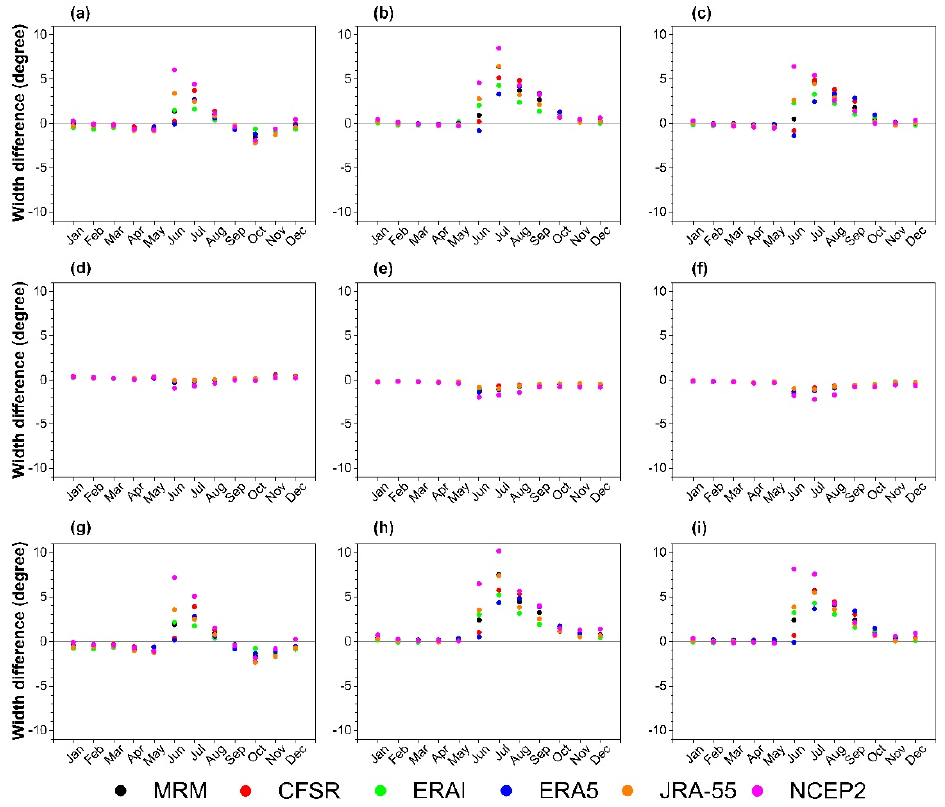
Figure 9. ( a – c ) Annual cycle of the difference between the uncorrected and corrected NH HCW derived from ( a ) M1, ( b ) M2, and ( c ) M3 using the MRM (black), CFSR (red), ERA-Interim (green), ERA5 (blue), JRA-55 (orange), and NCEP2 (magenta) data sets from 1979–2018. ( d – f ) and ( g – i ) Same as ( a – c ), but for the SH and TOT HCW, respectively. The units for the NH, SH, and TOT HCW difference are degrees.